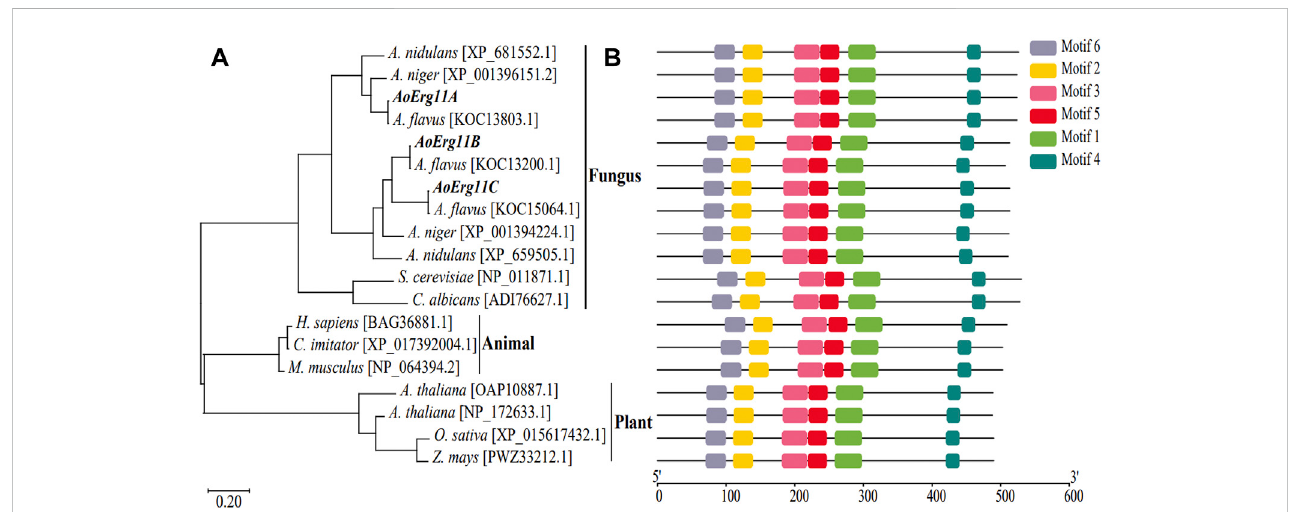
FIGURE 1 Phylogenetic analysis and functional motifs prediction of Erg11s in different species. (A) Unrooted phylogenetic tree of Erg11s and homologous proteins in A.nidulans , A.niger , A. fl avus , S.cerevisiae , C.albicans , H.sapiens , C.imitator , M.musculus , A.thaliana , O.sativa and Z.mays .TheIDsofthesequenceswere included after thespecie names in the fi gure. (B) All conserved motifs of theErg11swereidenti fi edby the MEME program. Protein sequences are indicated by thin black line, and the conserved motifs are represented by different colored